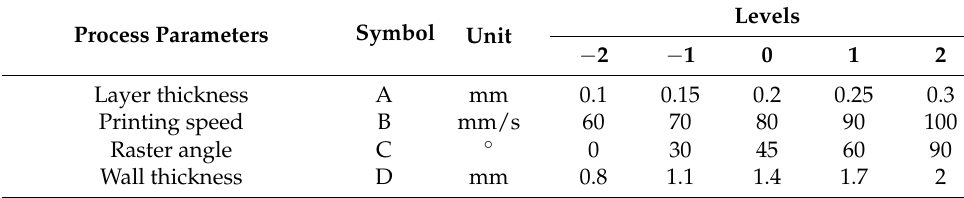
Table 3. Control process parameters and their levels.